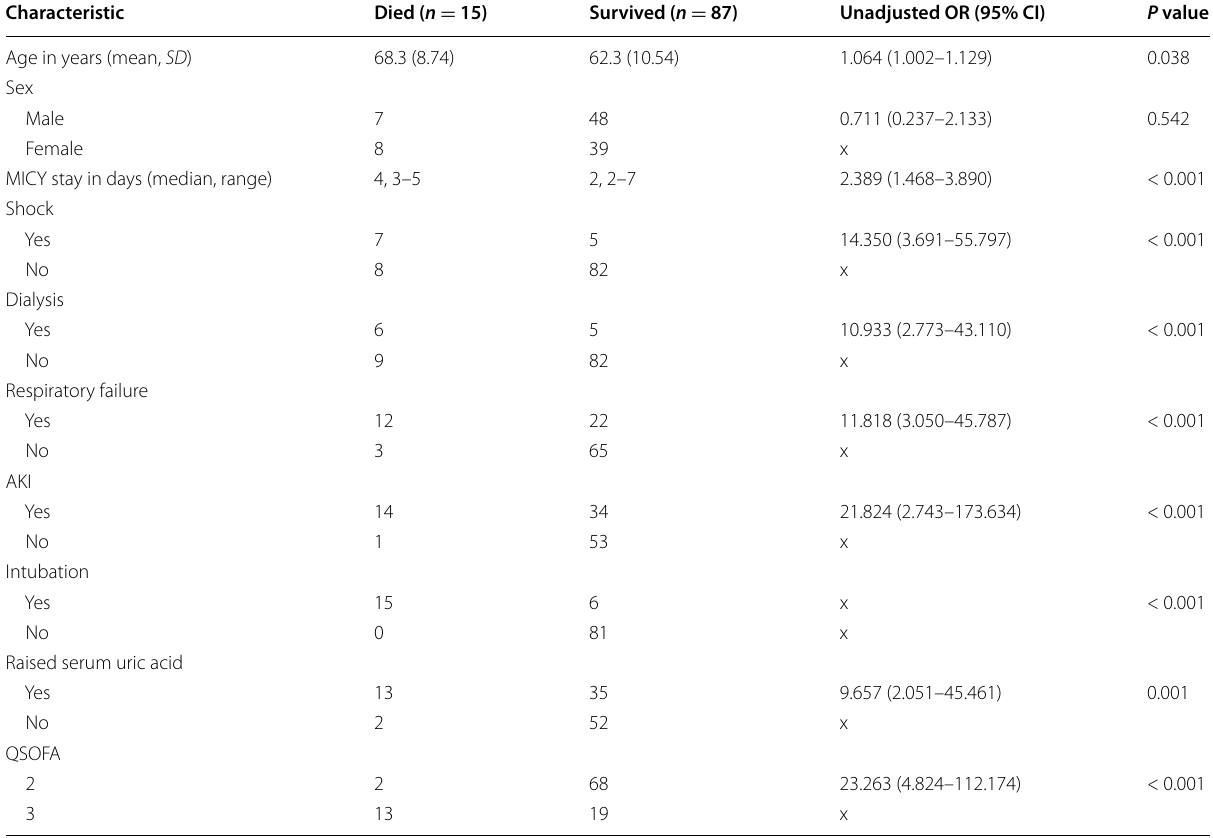
Table 2 Demographic and clinical parameters according to the